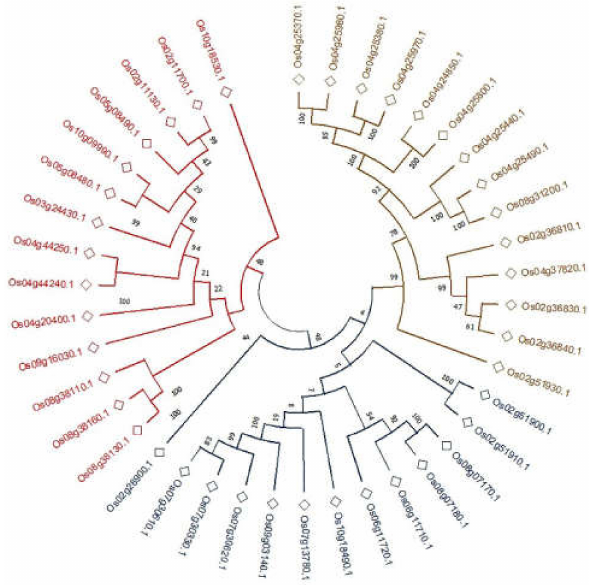
Figure 3. The phylogenetic tree of cytokinin-O-glucosyltransferase (CGT) genes belonging to family 1 was inferred using the neighbour-joining method. The bootstrap consensus tree inferred from 1000 replicates represents the evolutionary history of the taxa analysed. Branches corresponding